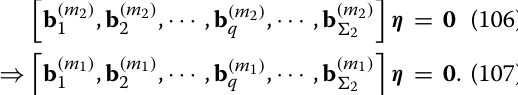
Table 2 Computational complexity